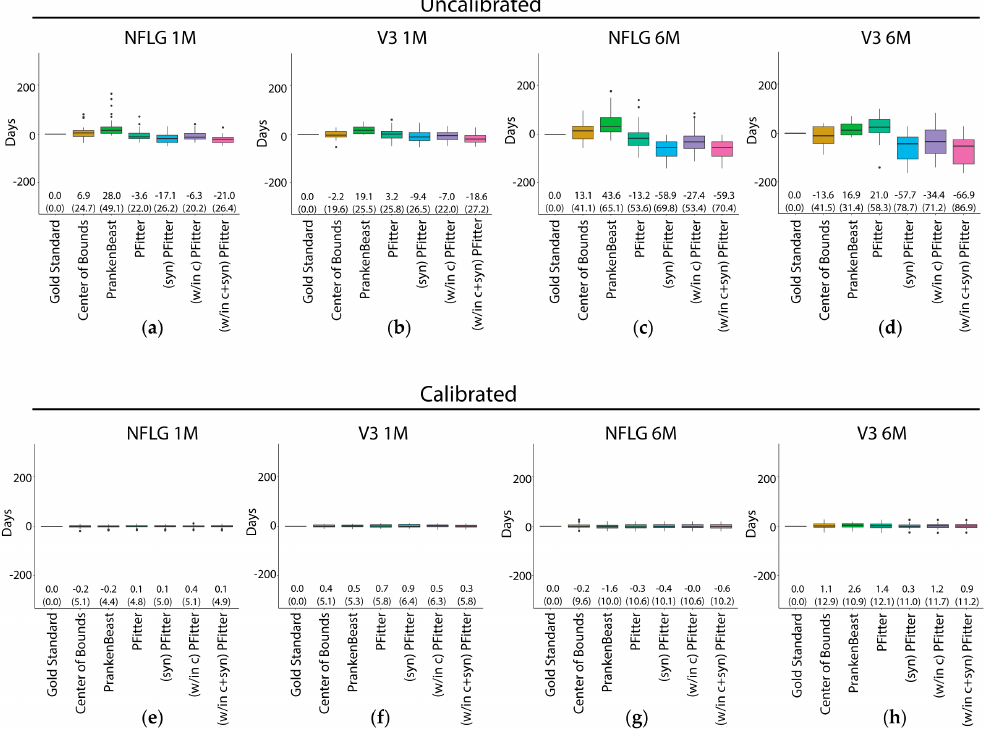
Figure 1. Prediction errors of the Center of Bounds, PrankenBeast, Poisson Fitter, and modified Poisson Fitter estimators of infection time before ( a – d ) and after ( e – h ) calibration for mutation rate after fitting a linear model with terms for log 10 plasma viral load (lPVL), the interaction of the estimator with